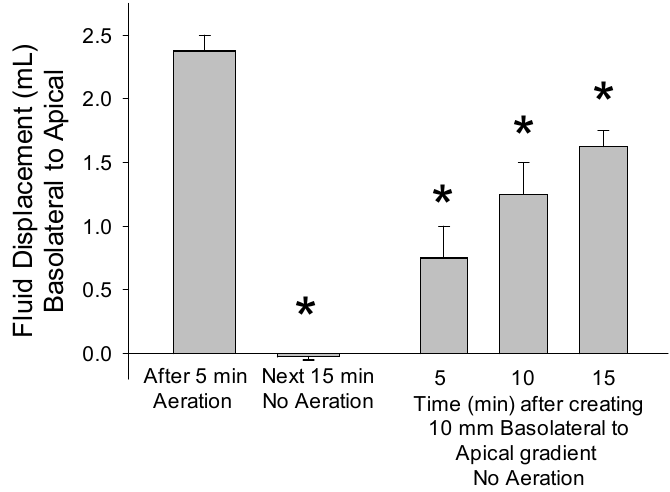
Figure 5. Mouse enterocytes were plated on inserts with 12 µ m pores. After an apical-to-basolateral hydrostatic pressure gradient was established by 5 min of vigorous aeration (first bar), flow back to the basolateral chamber during the next 15 min, which would be negative, was minimal (second bar). The basolateral-to-apical gradient that was made by adding excess fluid to the basolateral chamber gradually diminished (bars 3–5). Asterisks indicate p < 0.01 for comparison with first bar for the volume of basolateral-to-apical fluid movement caused by 5 min of vigorous aeration ( n = 6 inserts for each bar originating from multiple mice).